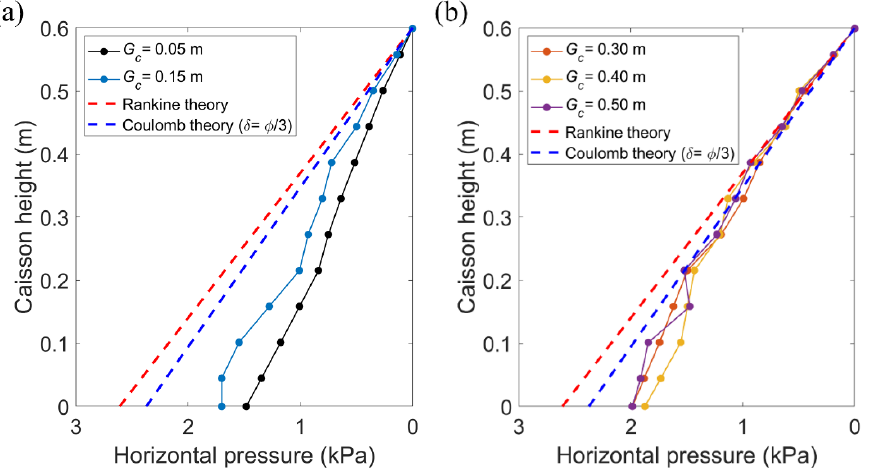
Figure 8. Comparison of the measured earth pressures with the values calculated according to Rankine’s and Coulomb’s theories for ( a ) G c < G cR and ( b ) G c ≥ G cR